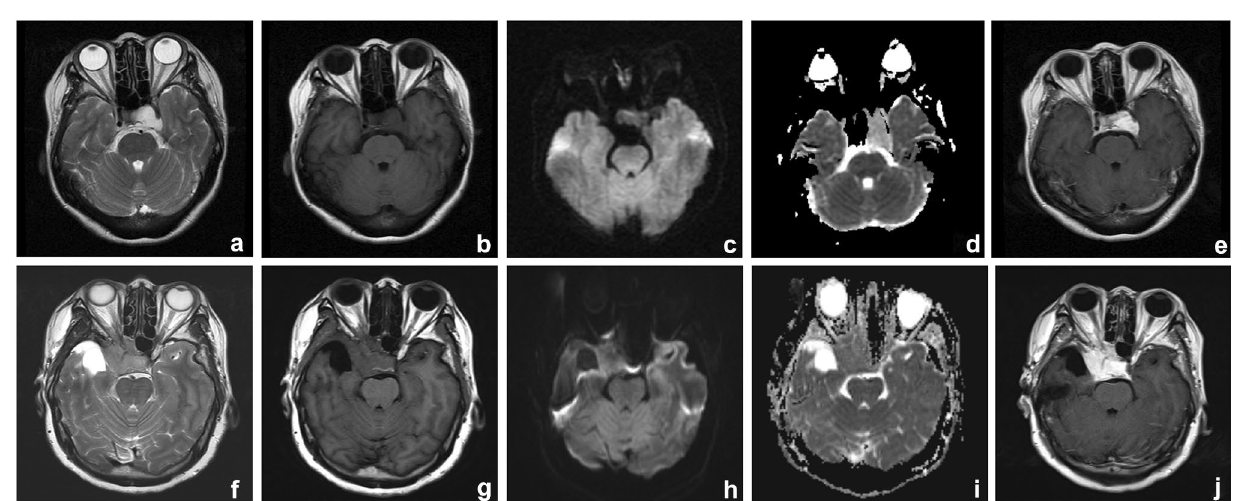
Figure 4. ( a – e ) Images of parasellar cavernous hemangioma in a 54-year-old woman. ( f – j ) Images of parasellar meningioma in a 58-year-old woman. MRI protocol included ( a , f ) axial T 2 -weighted images, ( b , g ), axial T 1 - weighted images, ( c , h ) diffusion-weighted images, ( d , i ) apparent diffusion coefficient maps, and ( e , j ) contrast- enhanced T 1 -weighted images. Cavernous hemangioma exhibited hyperintensity on T 2 -weighted images, hypointensity on T 1 -weighted images, DWI, and ADC map, and CE-T 1 WI showed homogeneous enhancement. Meningioma exhibited slightly hyperintensity on T 2 -weighted images, slightly hypointensity on T 1 -weighted images, DWI, and ADC map, and CE-T 1 WI showed homogeneous